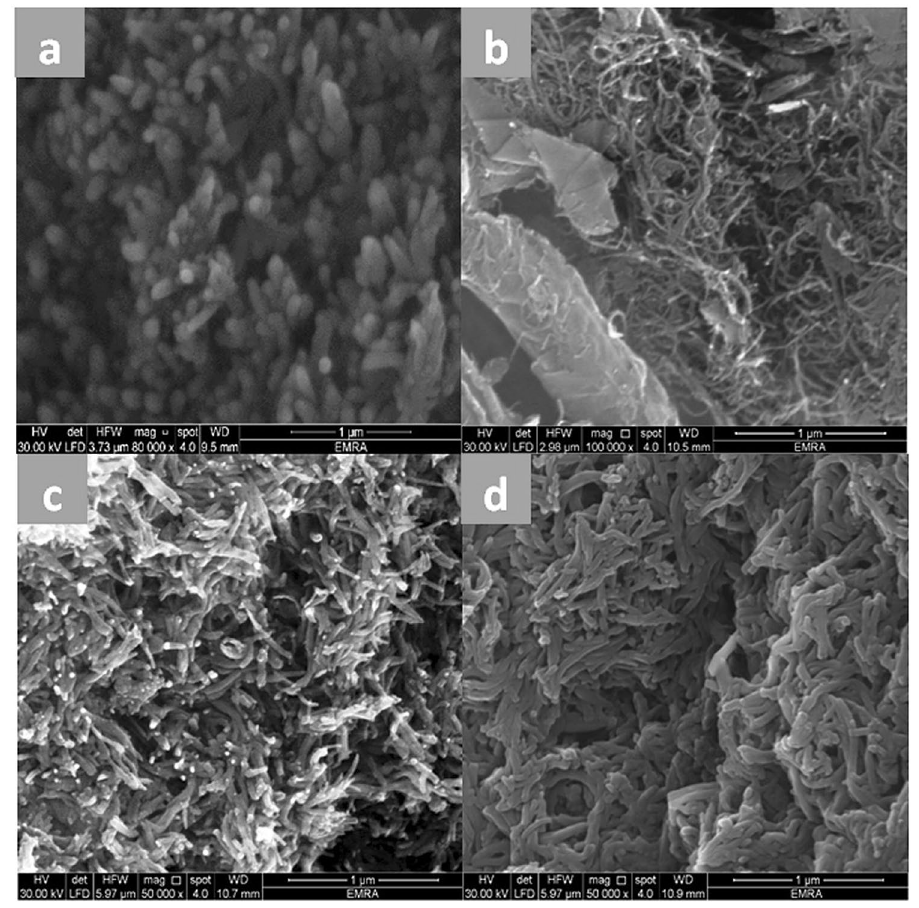
Figure 1. SEM images of CPA ( a ), N-SWCNTs-GO-CE ( b ), CPA/N-SWCNTs-GO-CE ( c ), and CPA/N- SWCNTs-GO-CE/CuO nanocomposites ( d